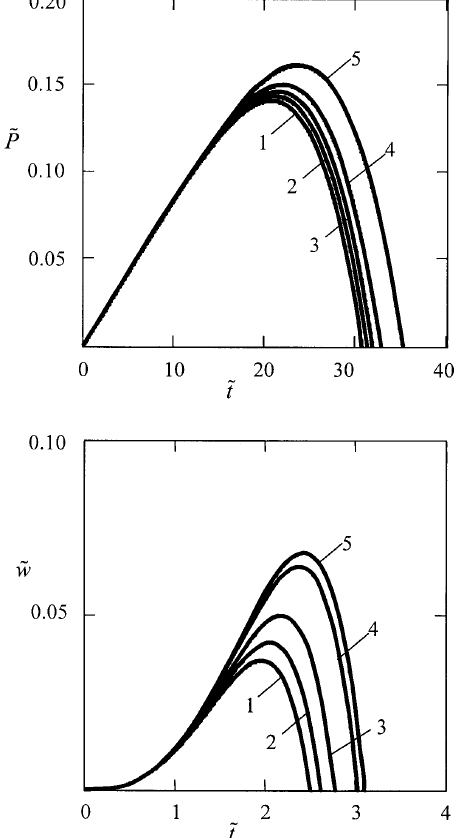
Fig. 3. The dimensionless time dependence of the dimensionless contact force and deflection at E θ /E r = 1 for a = 1 (curve 1), 0.75 (curve 2), 0.5 (curve 3), 0.25 (curve 4), and 0 (curve